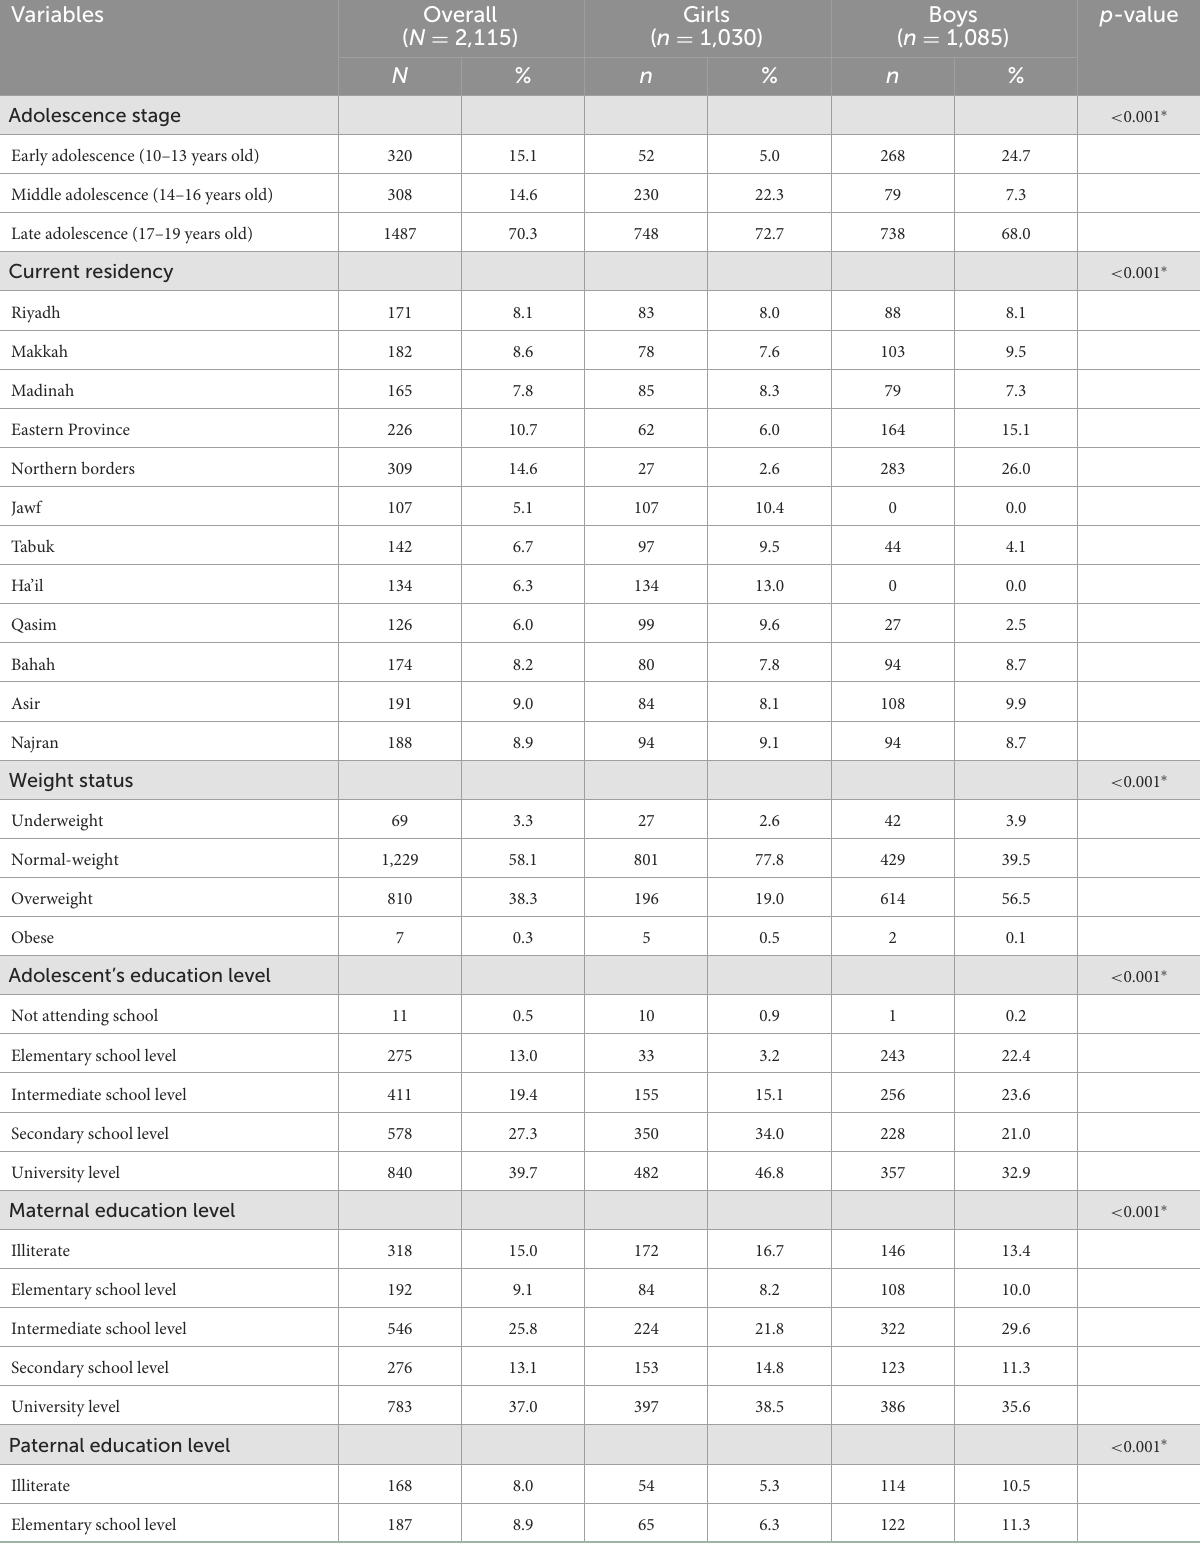
TABLE 2 Demographic, general characteristics and the BMI of